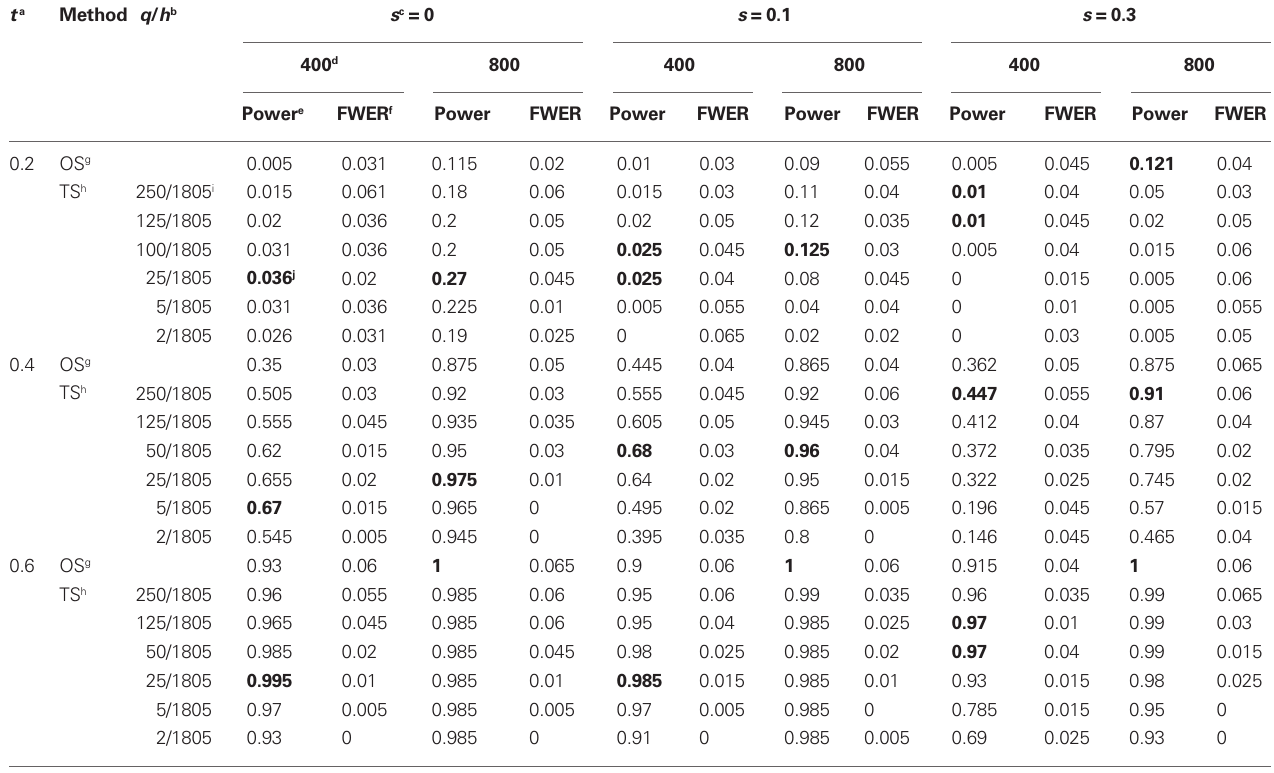
Table 2 | empirical power and FWer of the two-stage procedure at a significance level of 0.05 (200 replicates). t a method q / h